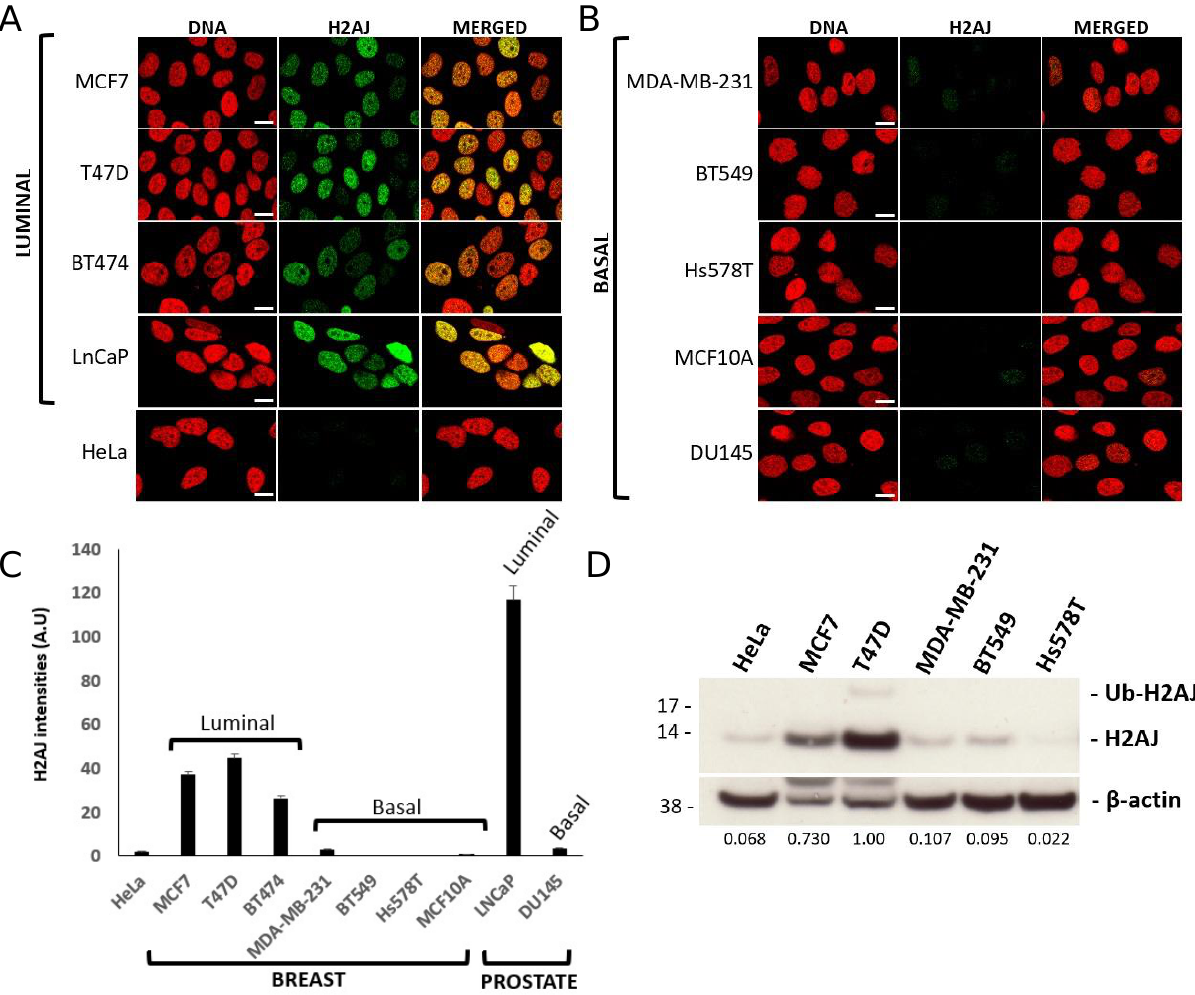
Figure 5. H2A.J protein is expressed at higher levels in breast and prostate cancer cell lines of luminal versus basal origin. ( A , B ) Immunofluorescent images with H2A.J-specific antibodies. All images were taken with the same exposure conditions. Scale bar = 10 µm. ( A ) Luminal breast (MCF7, T47D, BT474) and prostate (LnCAP) cancer cell lines [30,31]. HeLa cervical cancer cells were found to express low-levels of H2A.J relative to luminal cancer cells. ( B ) Basal or non-luminal breast (MDA-MB-2341, BT549, Hs578T, MCF10A) and prostate cancer cell lines [30–32]. ( C ) Quantification of the H2A.J signal intensities in the images shown in ( A , B ). Error bars represent standard errors of the mean. ( D ) H2A.J Western blot of the indicated cancer cell lines. ß-actin was used as a loading control. The numbers under the panels represent the intensity ratios for H2A.J/ß-actin signals normalized to the T47D ratio. Ub-H2AJ refers to a putative ubiquitinated form of